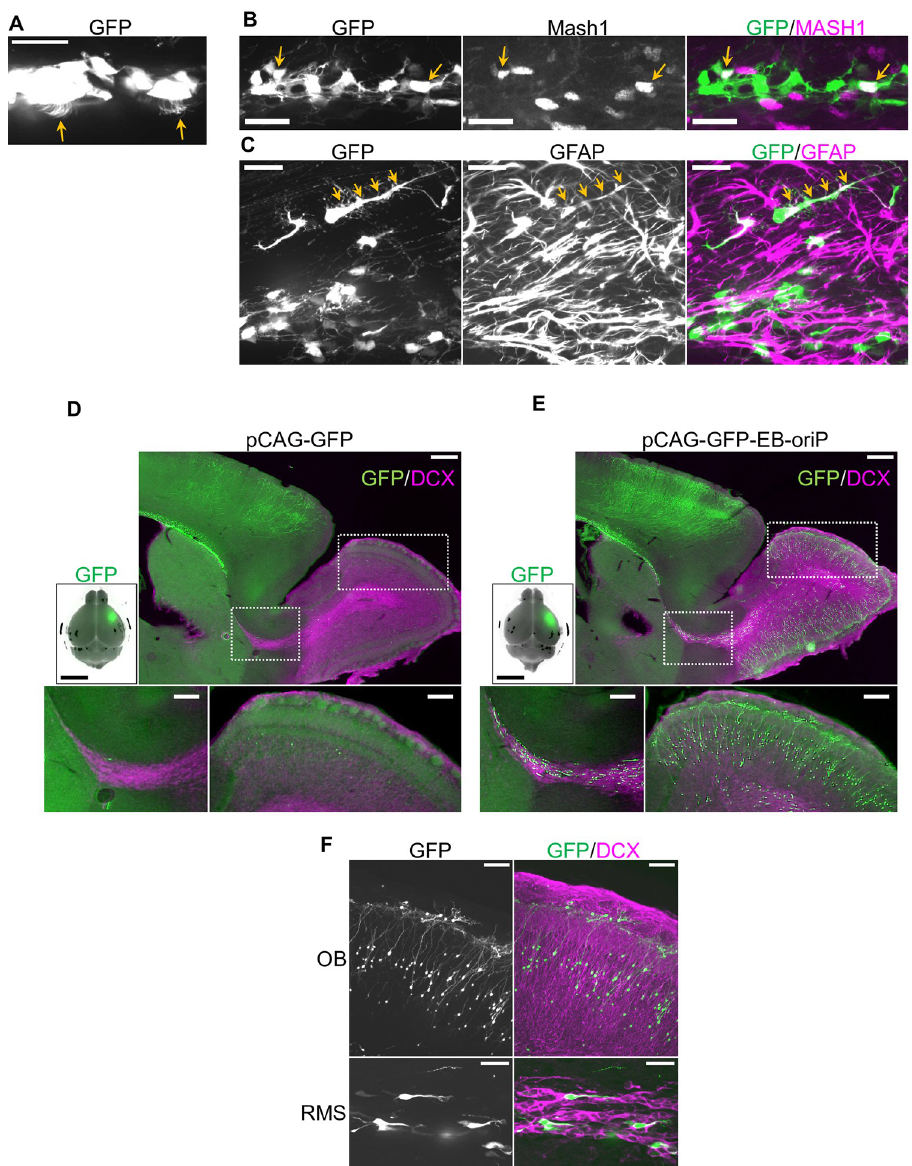
Fig 2. Transgene expression in E1 cells, C cells, B1 cells, and A cells by IUE of the EB-oriP plasmid in young adult mice. (A–C) Representative images of GFP-labeled cells in the brains transfected at E15 with pCAG-GFP-EB-oriP and observed at P21. (A) GFP-labeled cells appeared to be E1 cells (indicated by arrows), (B) Mash1-immunopositive C cells (indicated by arrows), and (C) GFAP-immunopositive B1 cell and its long process (indicated by arrows). Scale bars: 25 μ m. (D and E) Sagittal sections of the brains transfected at E15 with pCAG-GFP (D) and pCAG-GFP-EB-oriP (E) and fixed at P21 were immunostained for DCX. Merged images of GFP fluorescence and bright-field image of the brains used for sections are shown in upper left panels. The boxed regions in RMS (left) and OB (right), respectively, in upper right panels were magnified and shown in lower panels. Scale bars: 5 mm in upper left panel, 500 μ m in upper right panel, 200 μ m in lower panels. (F) Representative magnified images of GFP-labeled cells in OB (upper) and RMS (lower) in the section of pCAG-GFP-EB-oriP-transfected brain immunostained for DCX. Scale bars: 100 μ m in upper panels and 25 μ m in lower